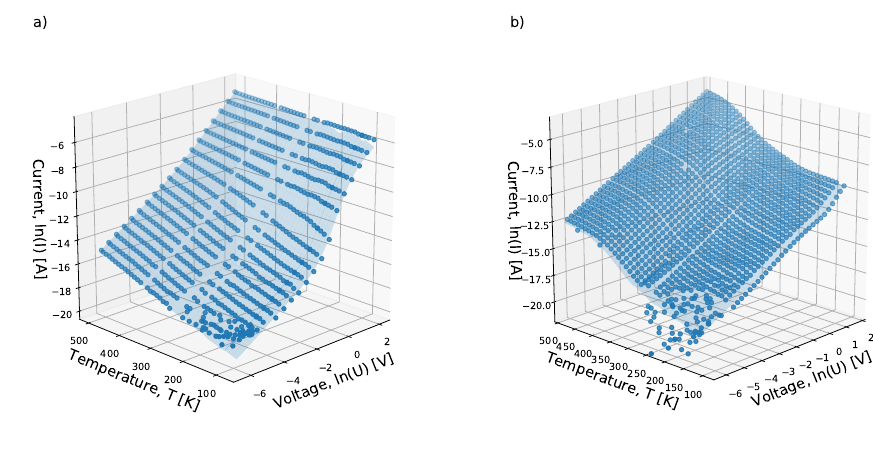
Figure 4. The gathered I − V − T characteristics in the forward configuration plot versus the temperature and the voltage for both developed heterojunctions ( a ) DFI and ( b ) DFII with a calculated hypothetical conducting